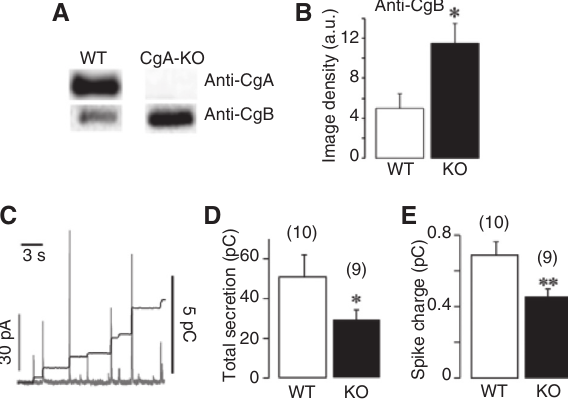
Figure 1 Secretory characteristics of the CgA-KO mouse. (A) Western blot of the adrenal medulla confirming the lack of CgA and the overexpression of CgB. (B) Quantification of CgB in the WT and CgA-KO as the average from six different analyses (means ± SEM). (C) Fragment from a typical amperometric trace from a KO chromaffin cell (units expressed in pAmperes – gray trace) with the cumulative secretion evident by integrating the original super- imposed trace (expressed in pCoulombs – black trace). (D) Analysis of cumulative secretion over a 2-min recording (mean ± SEM). (E) The net spike charge from WT and KO animals (Q, expressed in pC). The number of cells in each condition is shown in brackets: * p < 0.05; ** p < 0.01 Mann-Whitney test. Modified from (24).